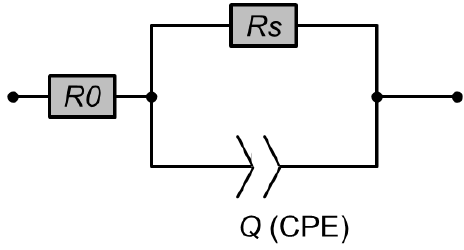
Figure 2. Equivalent circuit for the modeling of the impedance measurements. R0 is the resistance of the wires and the electrodes themselves. Rs is the bulk dc-resistance of the sample and Q is the constant phase element (CPE). 158